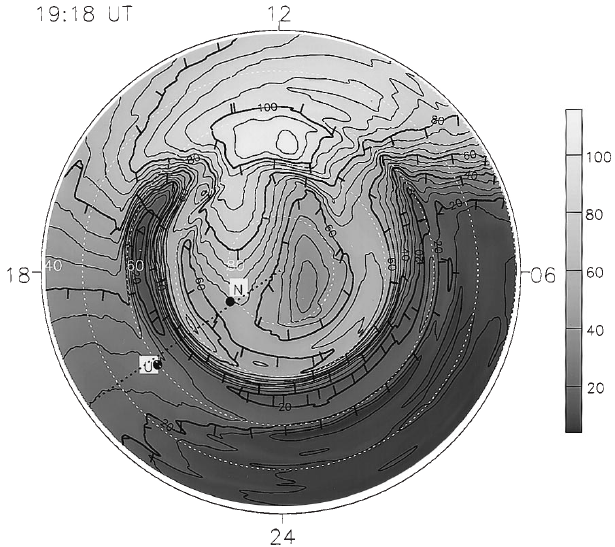
Fig. 1. Northern Hemisphere polar contour plot of modelled winter solstice NmF2 values extending down to 40 (cid:176) latitude. Values on the bold contours are in units of 10 10 m ) 3 . Contours are separated by 5 (cid:180) 10 10 m ) 3 . The tick marks on the bold contours show the direction in which NmF2 decreases. The dotted black line shows the simulated satellite path. Also shown are the positions of the southermost and northernmost receiving stations at Uppsala ( U ) and Ny A˚ lesund ( N ) respectively